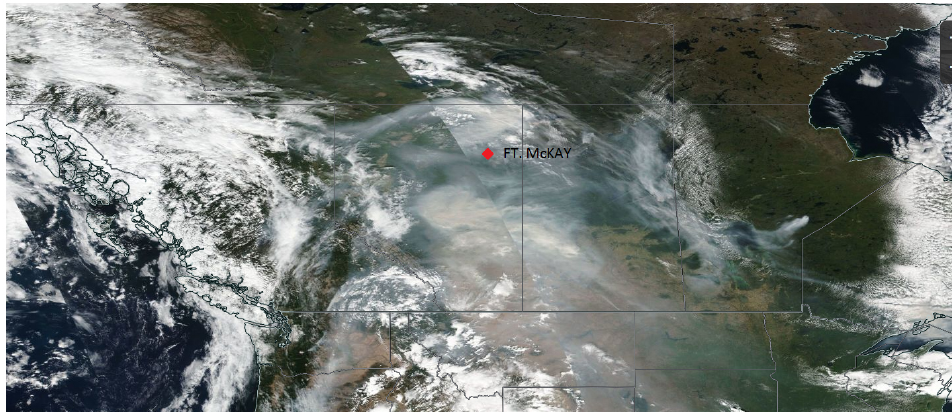
Figure 13. Terra MODIS true-color composite image on 31 August 2017. Note the location of the ground